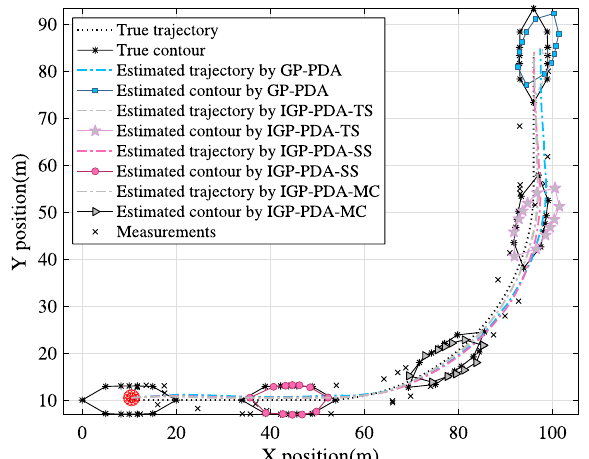
Fig. 4 True and estimates states in the first